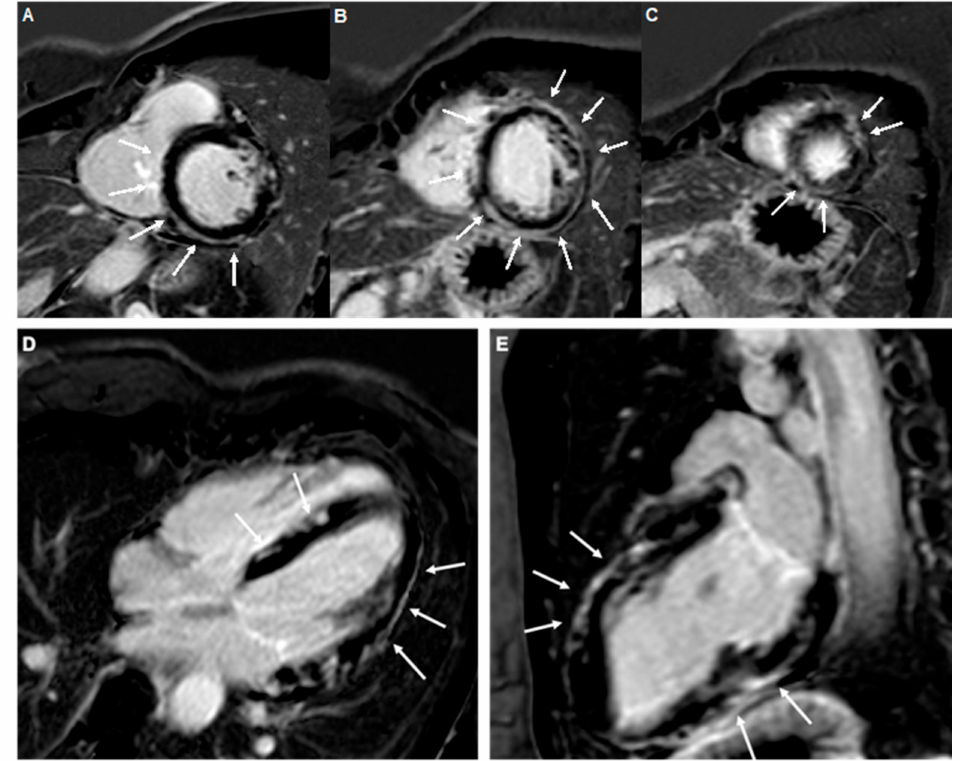
Figure 1. A prototypical example of extensive myocardial scarring due to myocarditis in a 35-year-old female tennis player. Contrast-enhanced cardiac magnetic resonance images ( A – C ), short axis views, ( D ), four-chamber view; ( E ), two-chamber view, showing an almost circumferential subepicardial stria of late gadolinium enhancement involving the interventricular septum, inferolateral, lateral, and anterolateral walls of the left ventricle (white